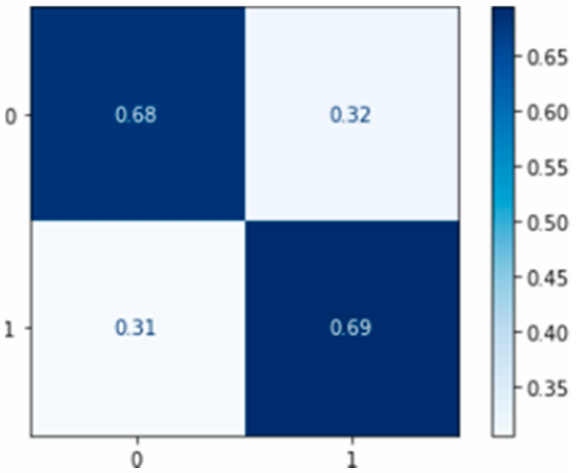
Figure 4. Confusion Matrix of the Artificial Neural